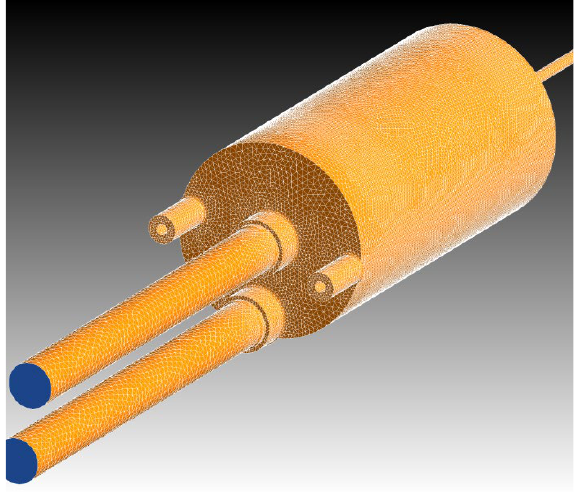
Figure 5. Domain discretization by tetrahedral cells.